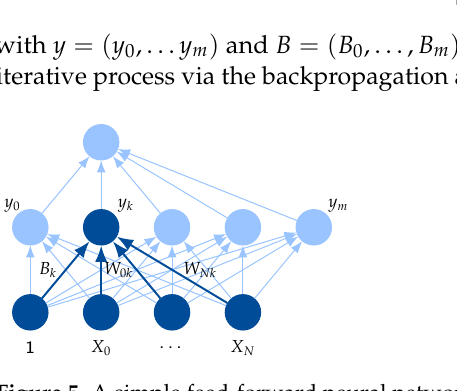
Figure 5. A simple feed-forward neural network. See text for details.